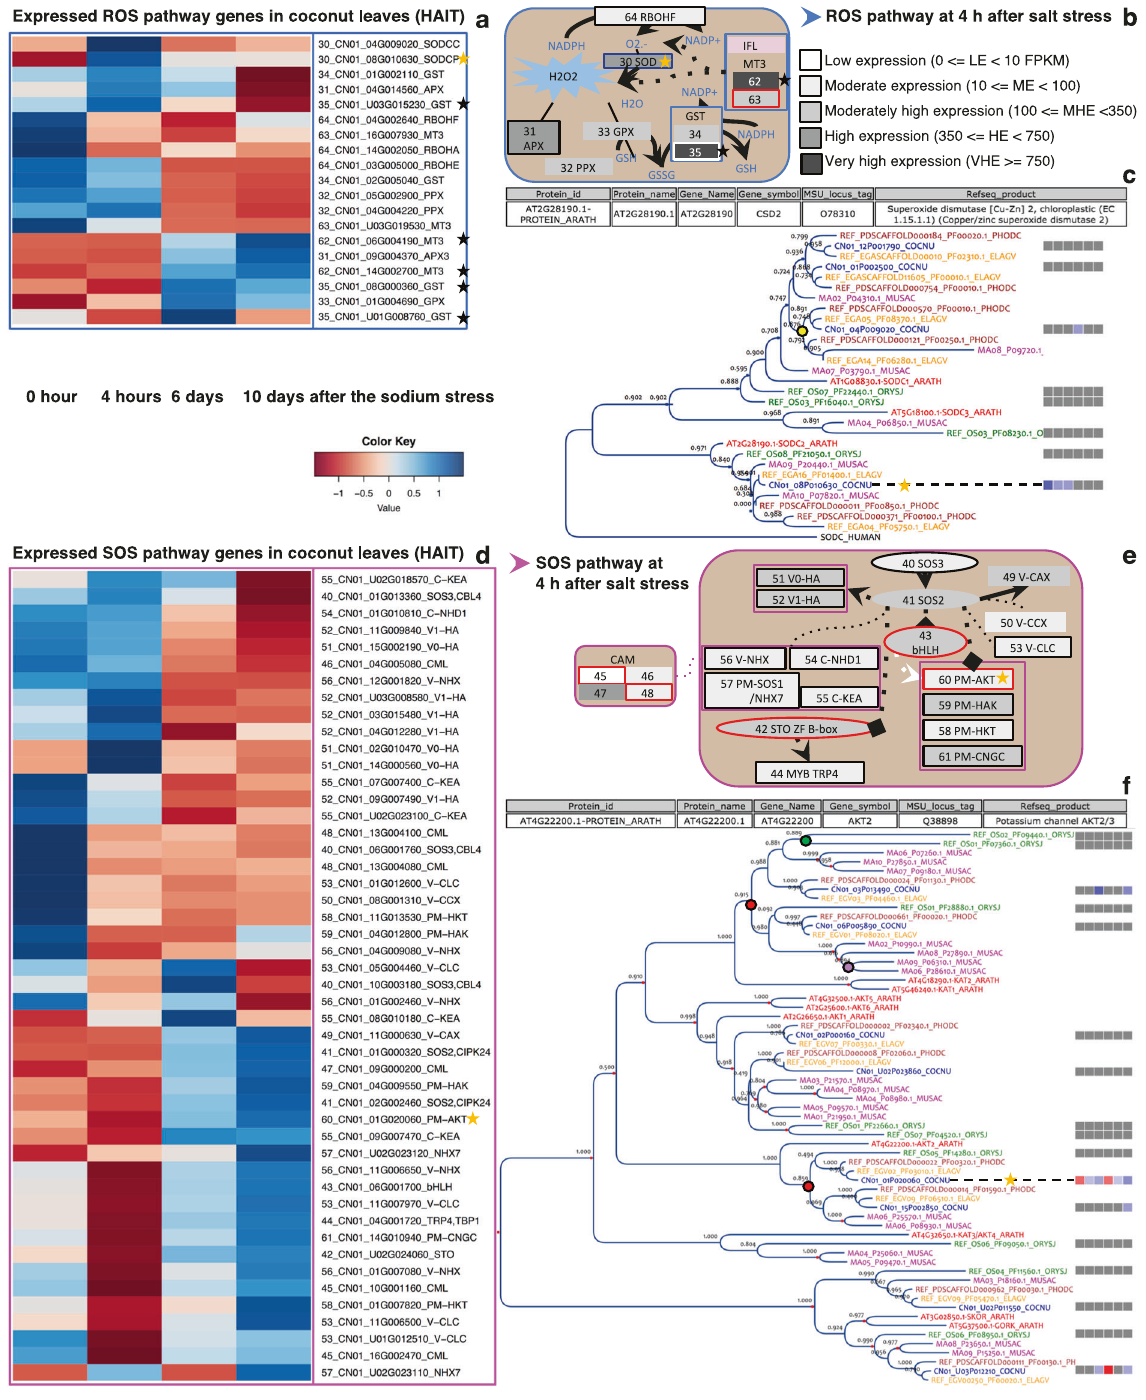
Fig. 6 Early gene regulation during salt stress in coconut leaves. a Normalized transcriptional expression level in Hainan tall leaves at time points 0, 4 h, 6 days, and 10 days after salt stress for the DE and CHE genes of the ROS pathway. Each gene is identi fi ed by its expression class number (ECN), gene identi fi er, and function symbol. b Schematic representation of the ROS signaling pathway at 4 h (see Supplementary Fig. S9 for more details). c Gene phylogeny of the SODC family across coconut (COCNU), date palm (PHODC), oil palm (ELAGA), banana (MUSAC), japonica rice (ORIZJ), and Arabidopsis (ARATH). Colored bullets represent WGDs (yellow, red, purple, and green for respectively p, τ , α / β / γ , and ρ / σ WGDs). Expression differential of coconut genes is displayed with blue and red squares for up and downregulation, respectively. The fi rst three columns are for the Hainan tall variety 4 h, 6 days, and 10 days) and the last three for the aromatic dwarf variety. Note that SODCP candidate gene CN01_08G010630 (yellow star) is orthologous to AT2G28190 whose annotation is given in the box above the tree. See Supplementary Note 1 for results on the MT3 and GST genes (gray stars). d , e Same as ( a , b ) for the SOS pathway. f Same as ( c ) for the Shaker gene family. Note that AKT2 candidate gene CN01_01G020060 (yellow star) is orthologous to AT4G22200 whose annotation is given in the box above the